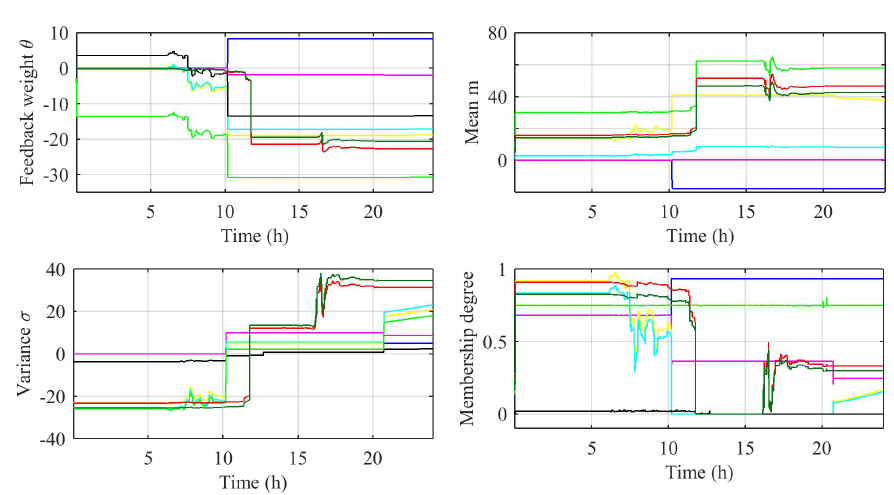
Figure 14. ( a ) Feedback weight θ , ( b ) mean m ( c ) variance σ , and ( d ) membership degree.